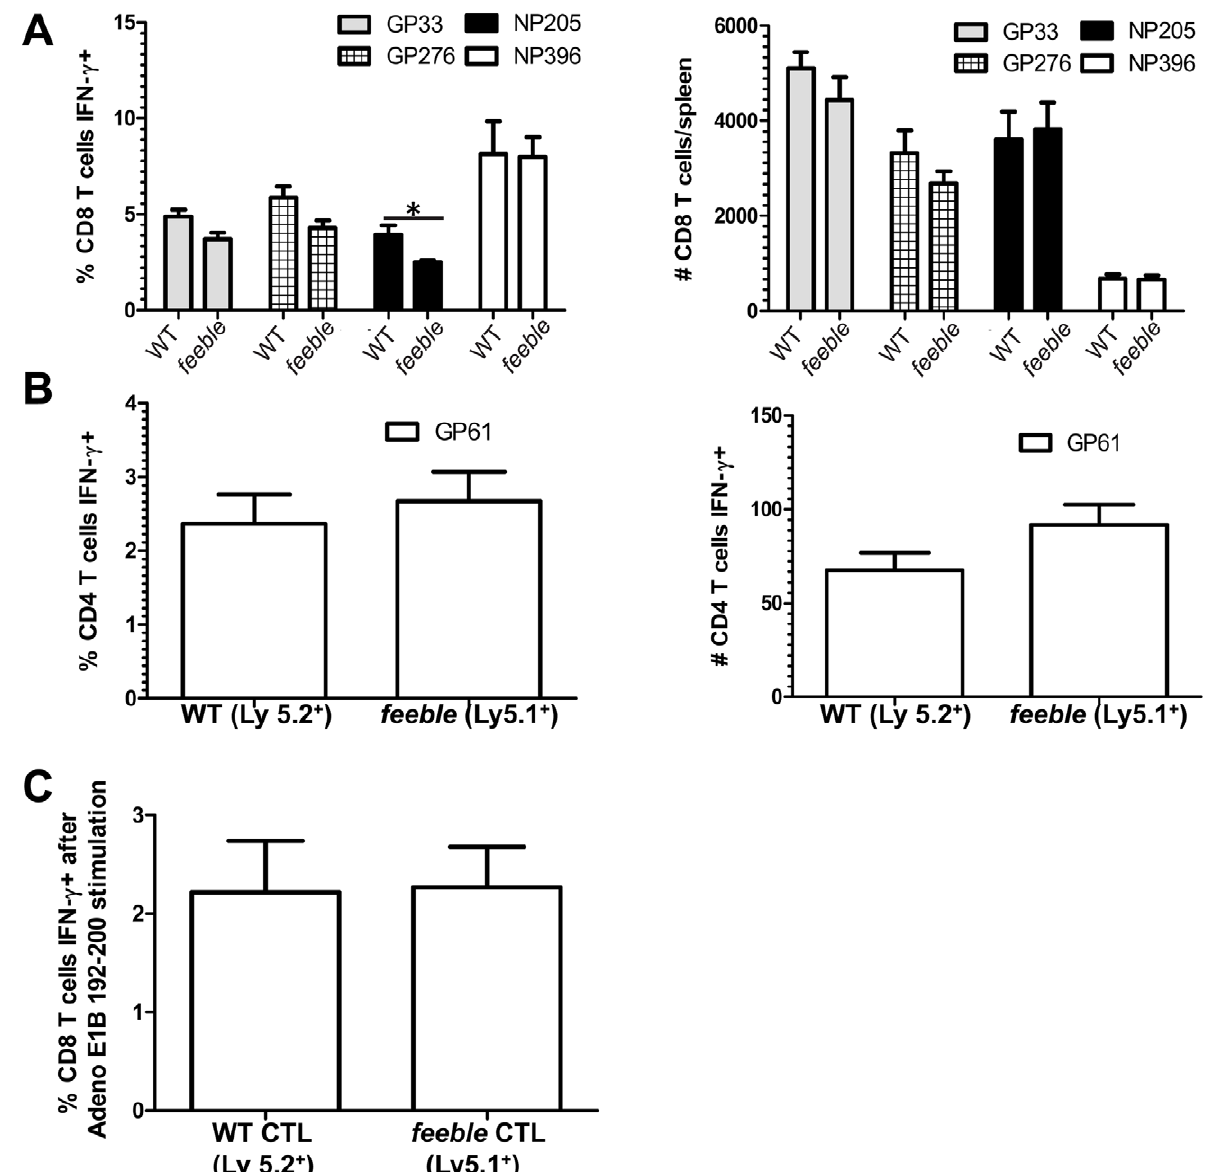
Figure 3. Defect in antigen specific feeble T cell responses is extrinsic. Equal numbers of bone marrow progenitors were harvested from WT and feeble mice and transferred into feeble recipients to generate mixed bone marrow chimeras. . 8 weeks post irradiation, mixed bone marrow chimeras were challenged with LCMV Cl13. Eight days post infection splenocytes were harvested, counted, cultured with the indicated peptides for 5 hours, stained with antibodies, and analyzed by flow cytometry IFN- c production in CD8 + (A) and CD4 + (B) antigen specific T cells. In (C) mice were primed with TAP1 2 / 2 5E1 fibroblasts expressing the model antigen from Adeno E1B. Seven days after i.p. injection splenocytes from mixed bone marrow chimeras (prepared as above) were cultured ex vivo with the immunodominant antigen for 5 hours. Then IFN- c expression was quantitated in CD8 + T cells by flow cytometry. Mean and standard error of the mean are shown. Feeble , Slc15a4 feeble/feeble mice. n=5 per group of mice. 1 of 2 similar experiments is shown. Unless marked, p . 0.05 between WT and feeble and not statistically significantly